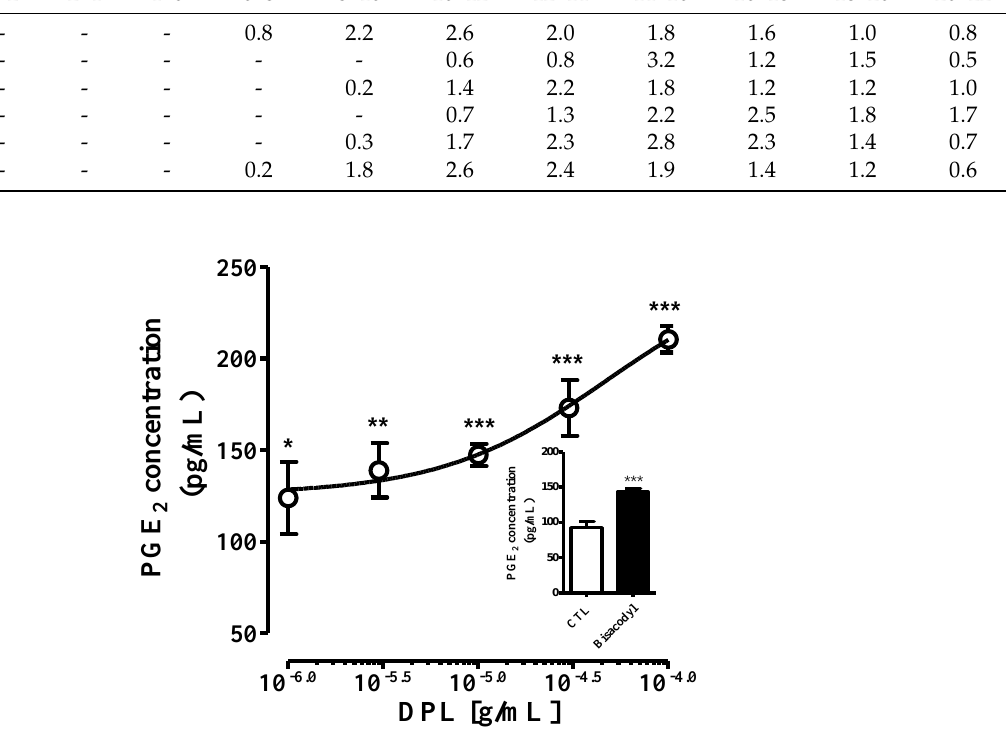
Figure 8. Changes in prostaglandin E2 (PGE 2 ) levels in RAW264.7 cells. Thirty minutes after the treatment of D. morbiferus H. L é v. leaf extract (DPL), the supernatant was collected, and the levels of PGE 2 were measured by using enzyme immunoassay (EIA). RAW264.7 cells were administrated with bisacodyl (10 µ g/mL) and recovered 30 min later (insert). Each data point represents the mean ± SD of six experiments. * Significant difference at p < 0.05, ** at p < 0.01, and *** at p < 0.001 compared with the control group (control group;